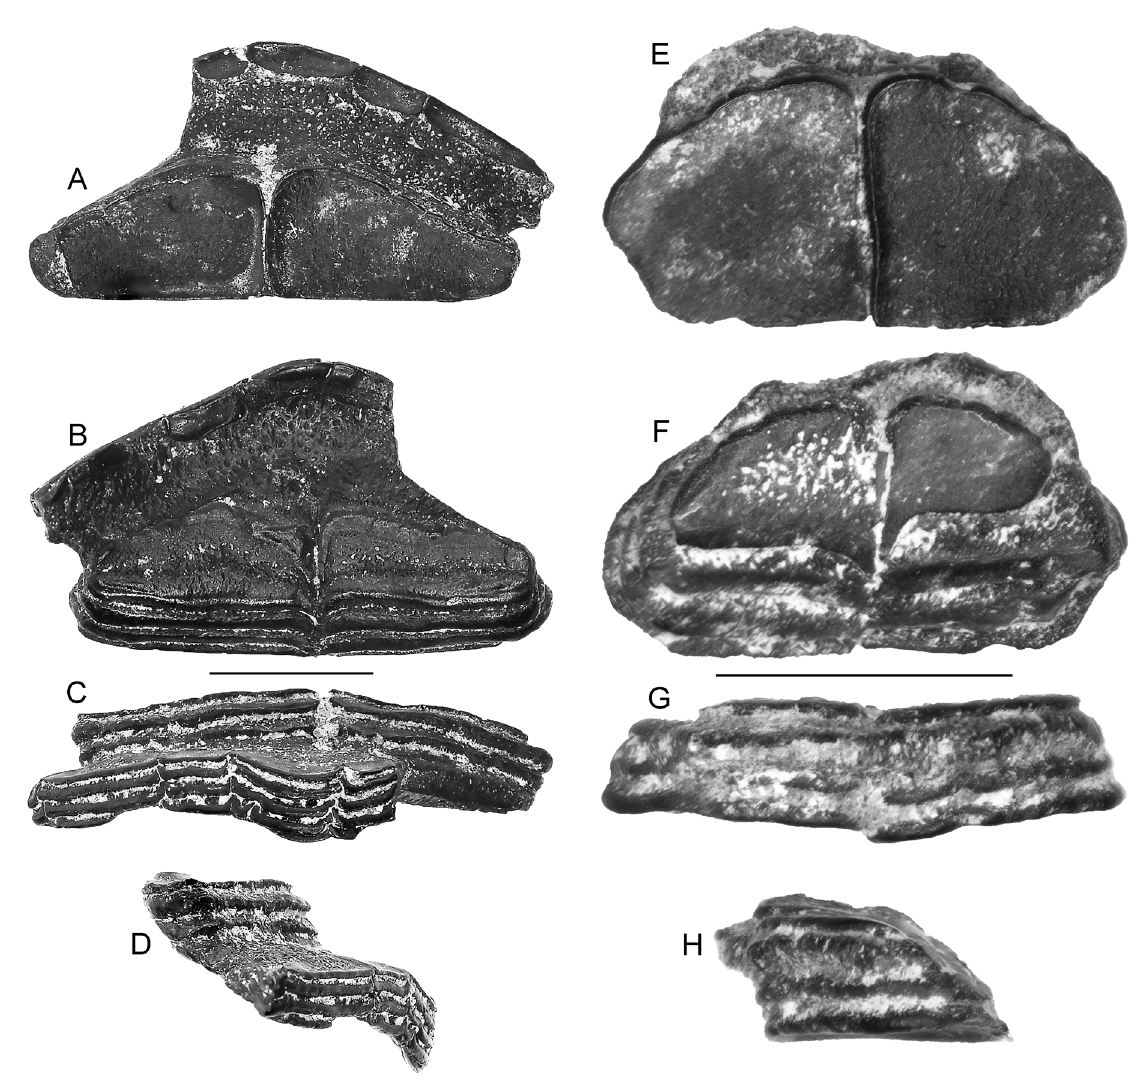
Fig. 68. Progymnodon hilgendorfi Dames, 1883, tooth plates. A–D . MSC 37450, basal Gosport Sand, upper tooth plate. A . Aboral view. B . Oral view. C . Posterior view. D . Profile view. E–H . MSC 37398.1, basal Gosport Sand, tooth plate. E . Aboral view. F . Oral view. G . Posterior view. H . Profile view. Scale bars: A–D = 1 cm; E–H = 5 mm. Anterior at top in oral and